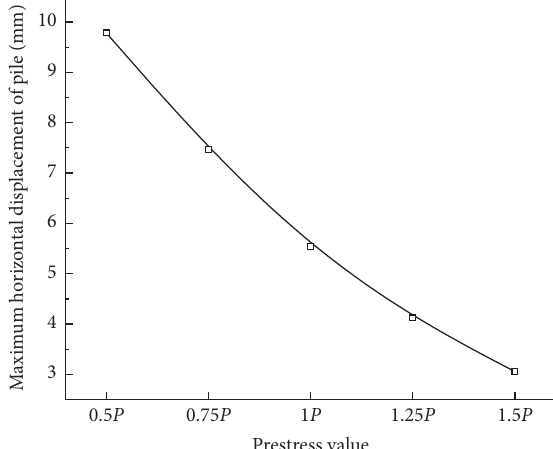
Figure 9: Influence of prestress on maximum horizontal displacement of the